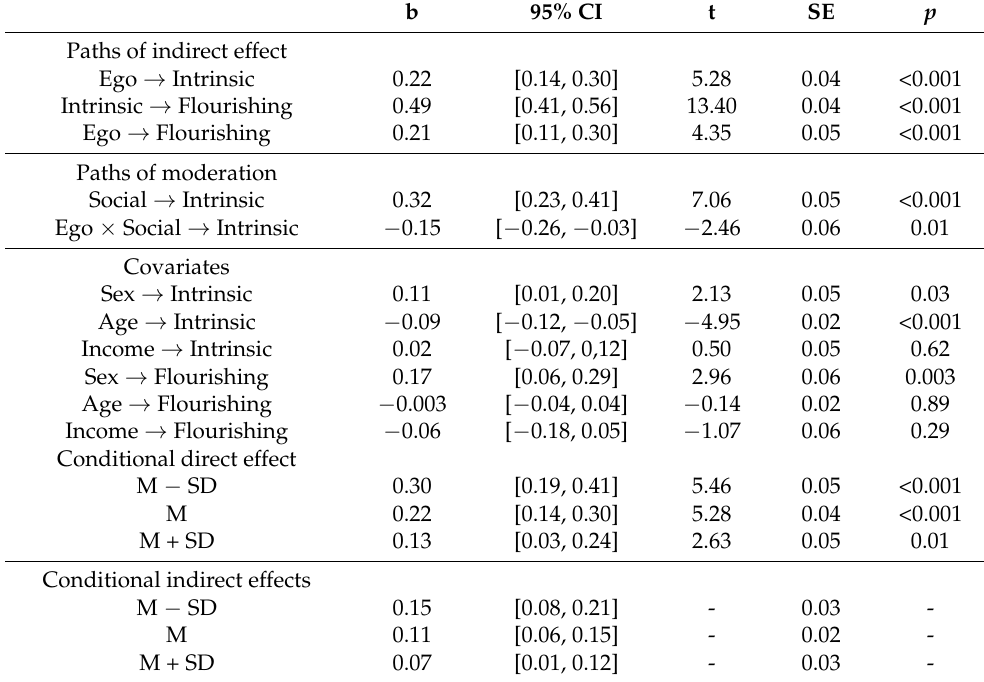
Table 3. Associations between ego identity exploration, intrinsic motivation, social capital and flourishing (N =